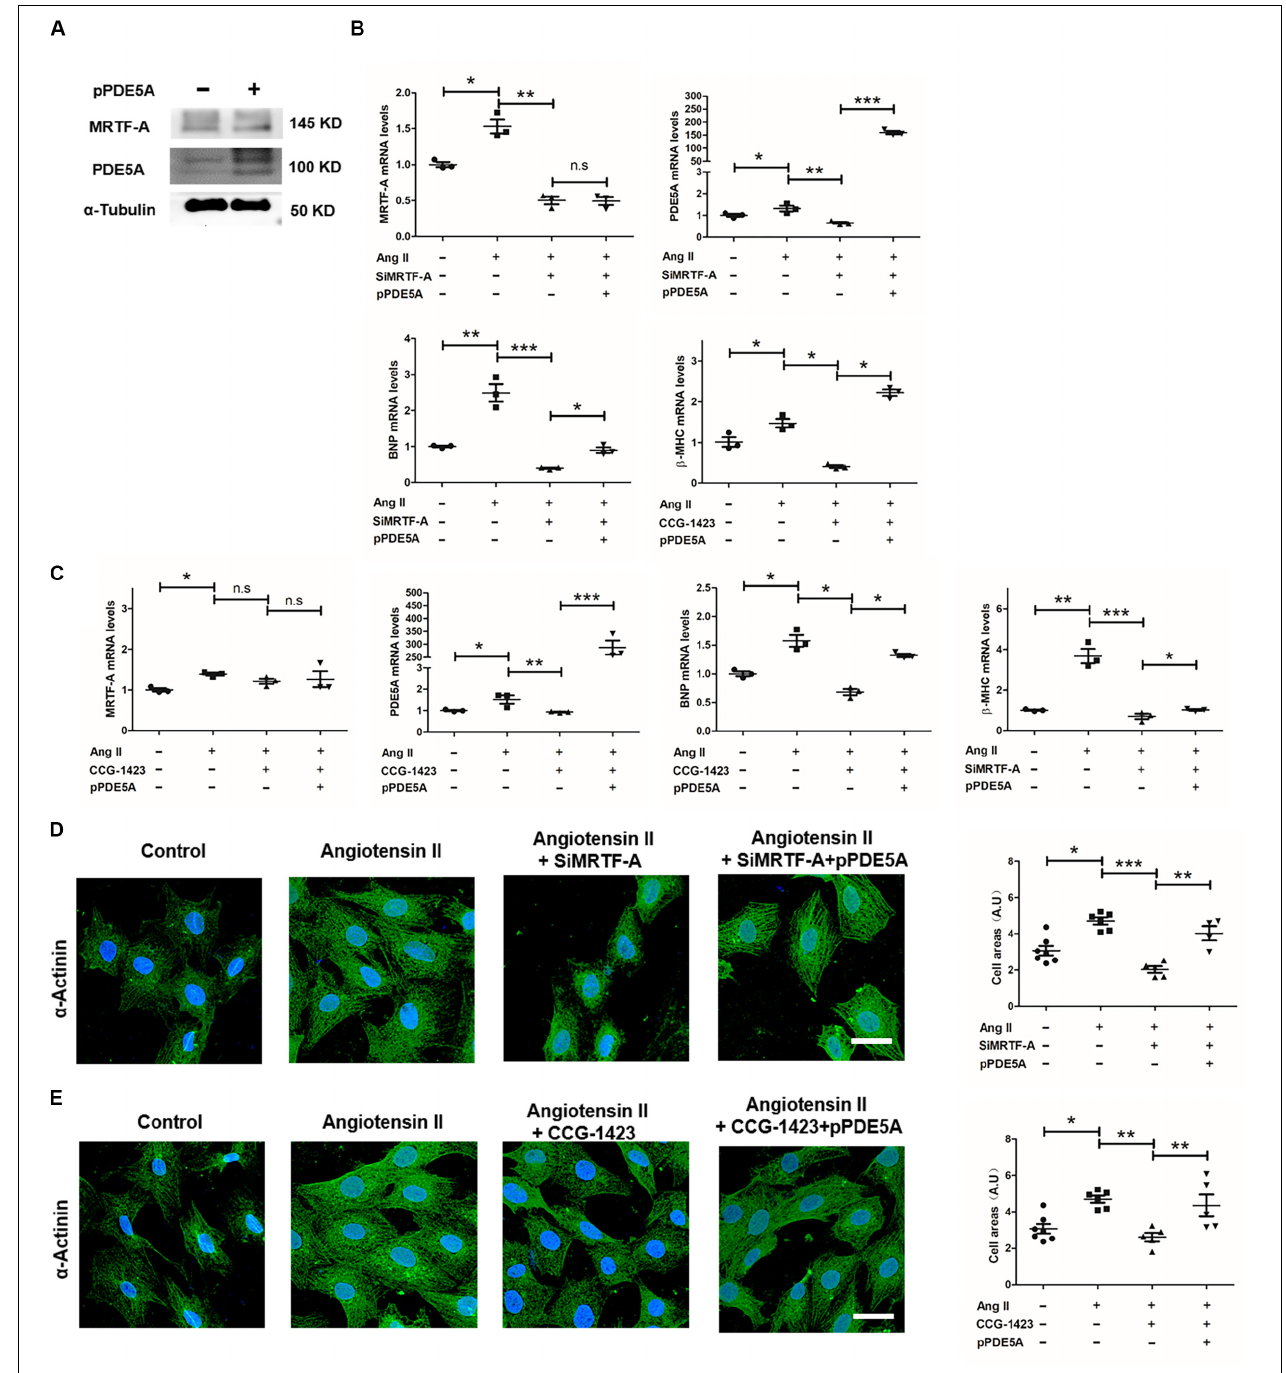
FIGURE 4 | Phosphodiesterase 5 (PDE5) is essential for myocardin-related transcription factor A (MRTF-A) to mediate Ang-II-induced prohypertrophic response in cardiomyocytes. (A) H9C2 cells were transfected with a PDE5A vector or an empty vector. Protein expression was examined by Western blot. (B) H9C2 cells were transfected with small interfering RNA (siRNA) targeting MRTF-A or scrambled siRNA (SCR) in the presence or absence of ectopic PDE5A followed by treatment with Ang II (1 µ M) for 24 h. Gene expression was examined by quantitative PCR (qPCR). (C) H9C2 cells were treated with Ang II (1 µ M) and CCG-1423 (10 µ M) in the presence or absence of ectopic PDE5A for 24 h. Gene expression was examined by qPCR. (D) H9C2 cells were transfected with siRNA targeting MRTF-A or scrambled siRNA (SCR) in the presence or absence of ectopic PDE5A followed by treatment with Ang II (1 µ M) for 24 h. Immunofluorescence staining was performed with anti- α -actinin. Cross-sectional areas were quantified by Image Pro. (E) H9C2 cells were treated with Ang II (1 µ M) and CCG-1423 (10 µ M) in the presence or absence of ectopic PDE5A for 24 h. Immunofluorescence staining was performed with anti- α -actinin. Cross-sectional areas were quantified by Image Pro. Data represent averages of three independent experiments, and error bars represent SEM. * p < 0.05; ** p < 0.01; *** p < 0.001. Scale bar: 25 µ m.